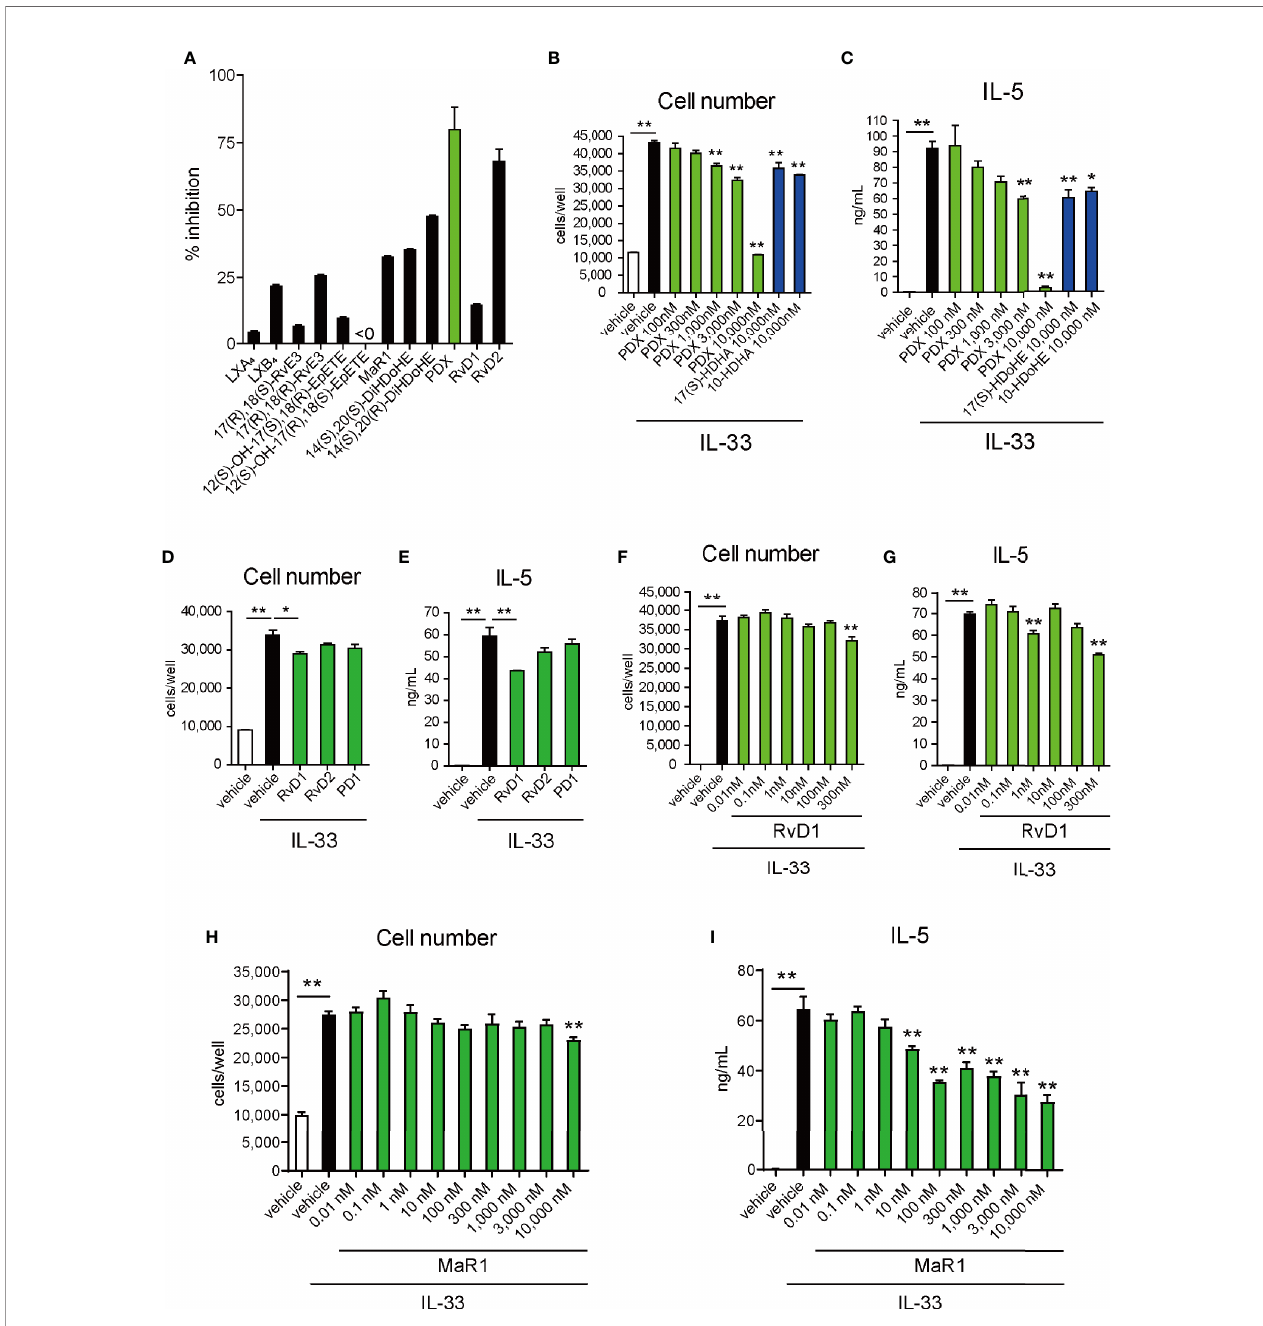
FIGURE 4 | Effects of SPMs on proliferation and cytokine production of ILC2s. (A) ILC2 cells (10,000 cells per well) were cultured with IL-33 (10 ng/mL) for 4 days in the presence or absence of (A) dihydroxy- or trihydroxy-lipid metabolites (LX, lipoxin; Rv, resolvin; MR, maresin; PD, protectin D: 10 -5 M) or in the presence or absence of (B, C) 10(S),17(S)-diHDoHE (PDX, 3 × 10 -7 – 10 -5 M), (D, E) 17(S)-HDoHE-derived SPMs (RvD1, resolvin D1; RvD2, resolvin D2; PD1, protectin D1: 3 x 10 -7 nM), (F, G) RvD1 (1 × 10 -11 – 3 x 10 -7 M: (D, E) , or (H, I) MaR1 (MaR1; maresin 1: 10 -11 – 10 -5 M). The total cell count (A, B, D, F, H) and concentrations of IL-5 (C, E, G, I) in the culture supernatant were measured. Data are shown as Mean ± SEM, n = 3 for each group. *P < 0.05, **P < 0.01 (Student ’ s t